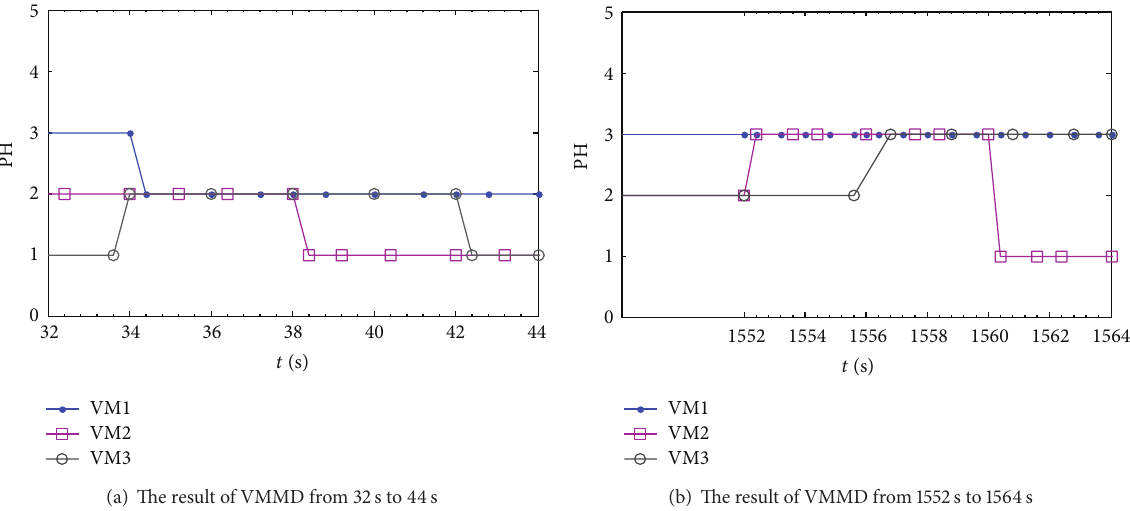
Figure 6: The result of VMMD based on CNN in different times.